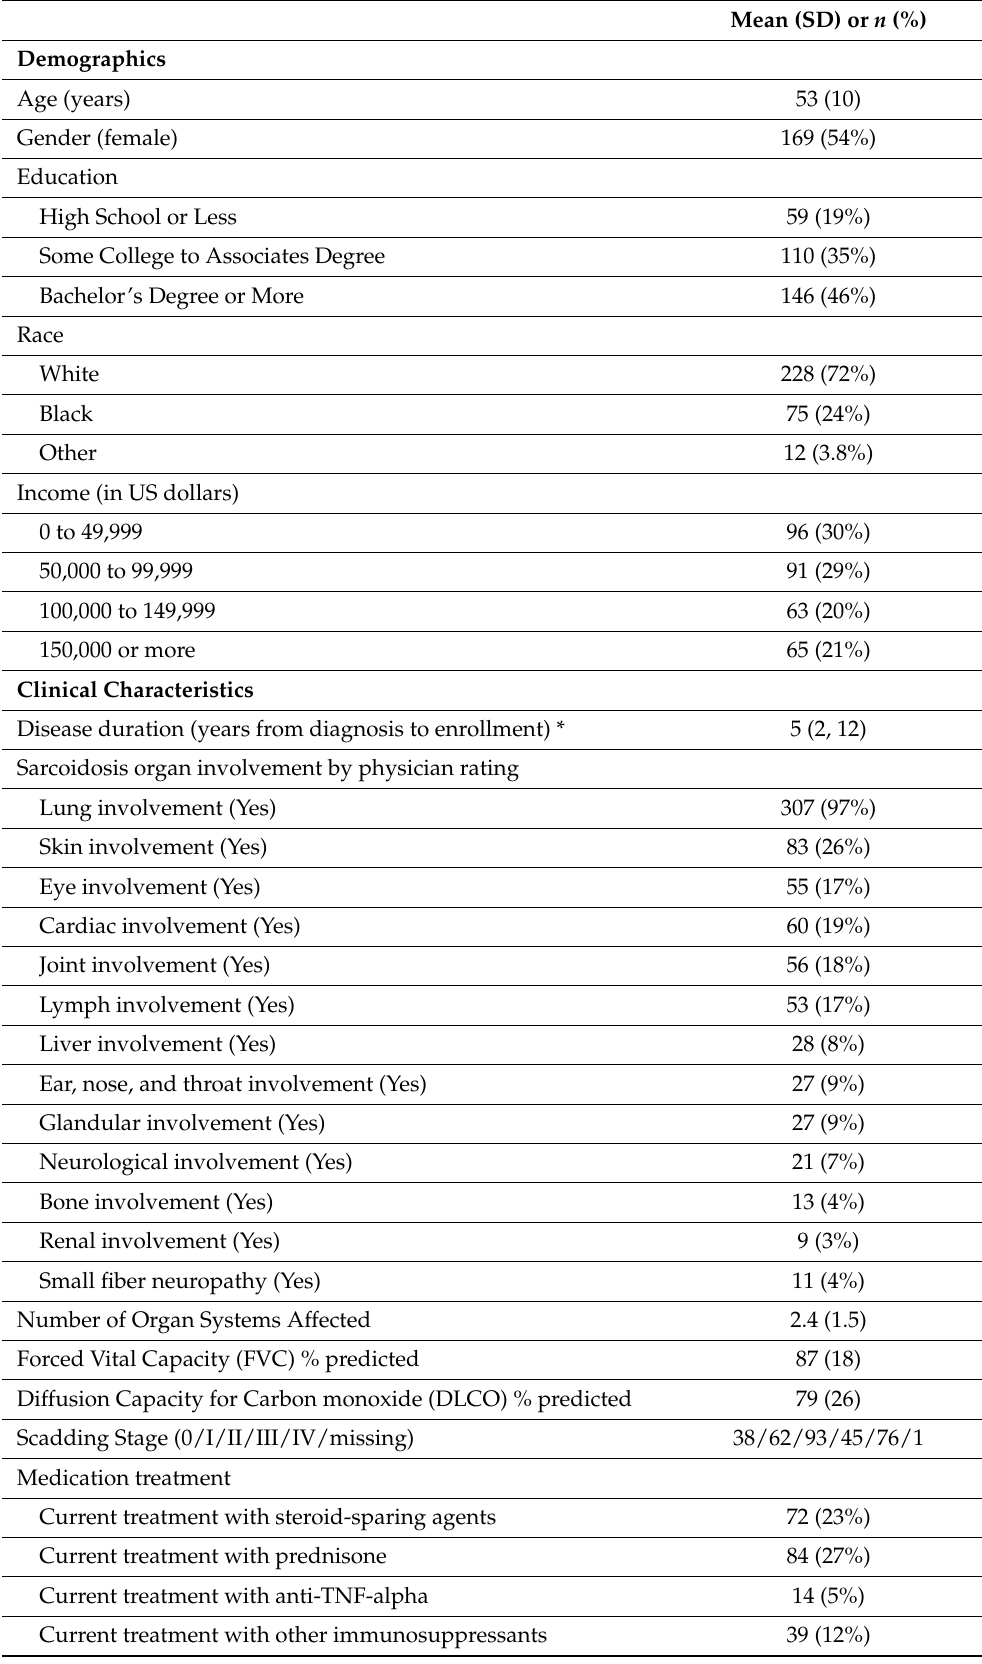
Table 1. Demographic and clinical characteristics of the sample ( n =